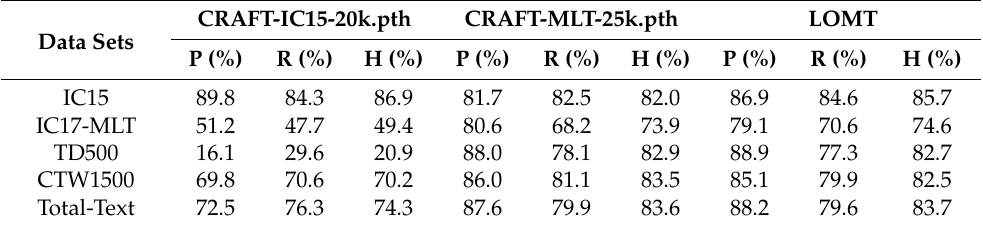
Table 4. Comparison of generalization experimental results. Data